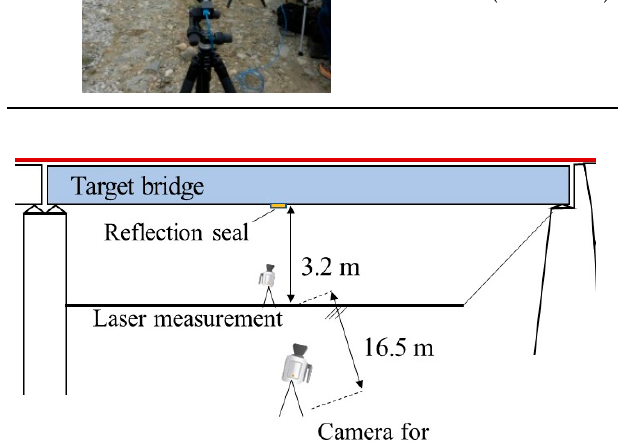
Figure 7. Installation status of each measuring device for bridge A.